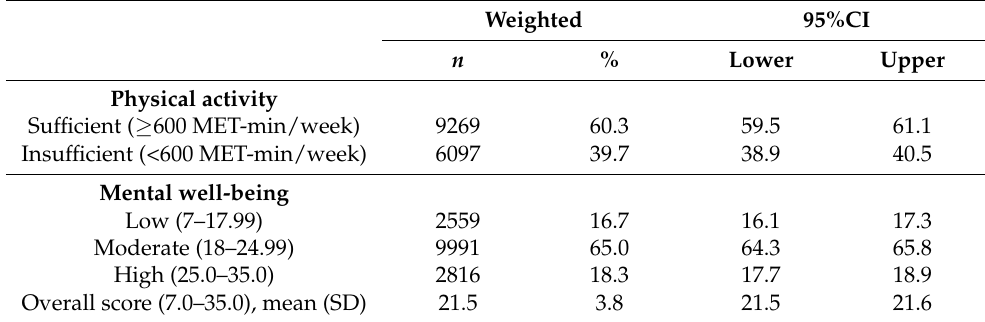
Table 2. Prevalence of health-related behaviors among ASEAN university students ( n =